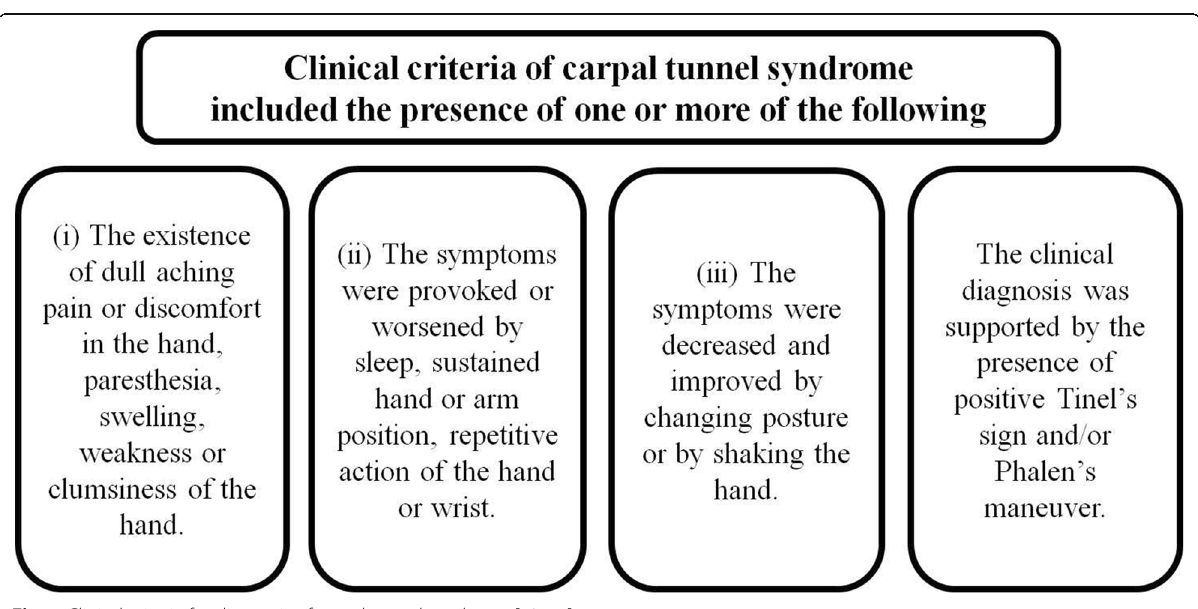
Fig. 1 Clinical criteria for diagnosis of carpal tunnel syndrome [13 –